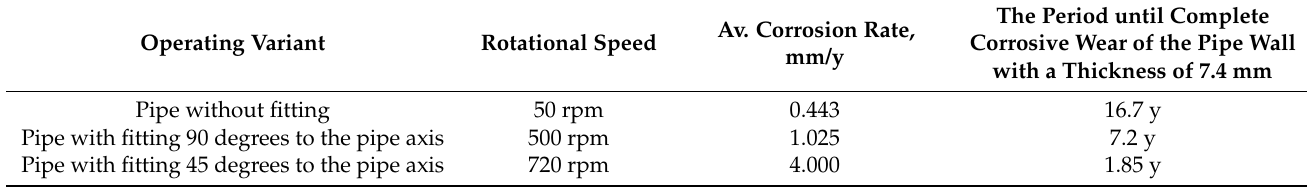
Table 6. Summary table of accident-free liner life with installed